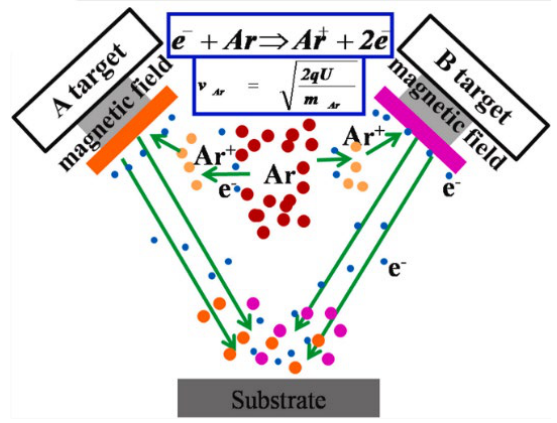
Figure 2. Magnetron sputtering